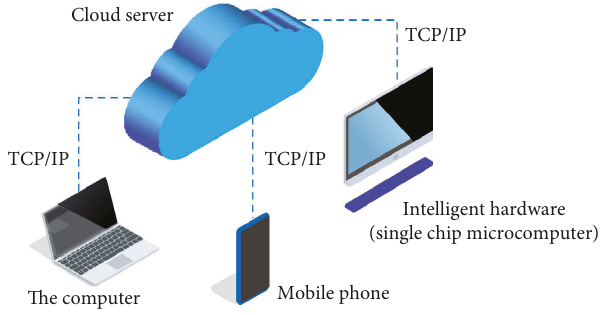
Figure 1: Internet of